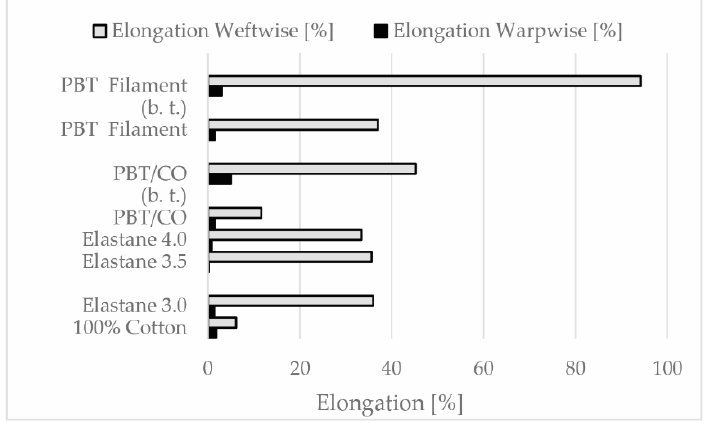
Figure 5. Elongation values (warp and weftwise) of fabric samples ((b.t.)—before thermal treatment). The shrinkage value of the PBT filament fabric sample and the fabric samples with elastane yarns was about 35% in the weft direction. In terms of elastic properties, the PBT filament and Co/PBT fabric samples showed higher elongation values in both directions.